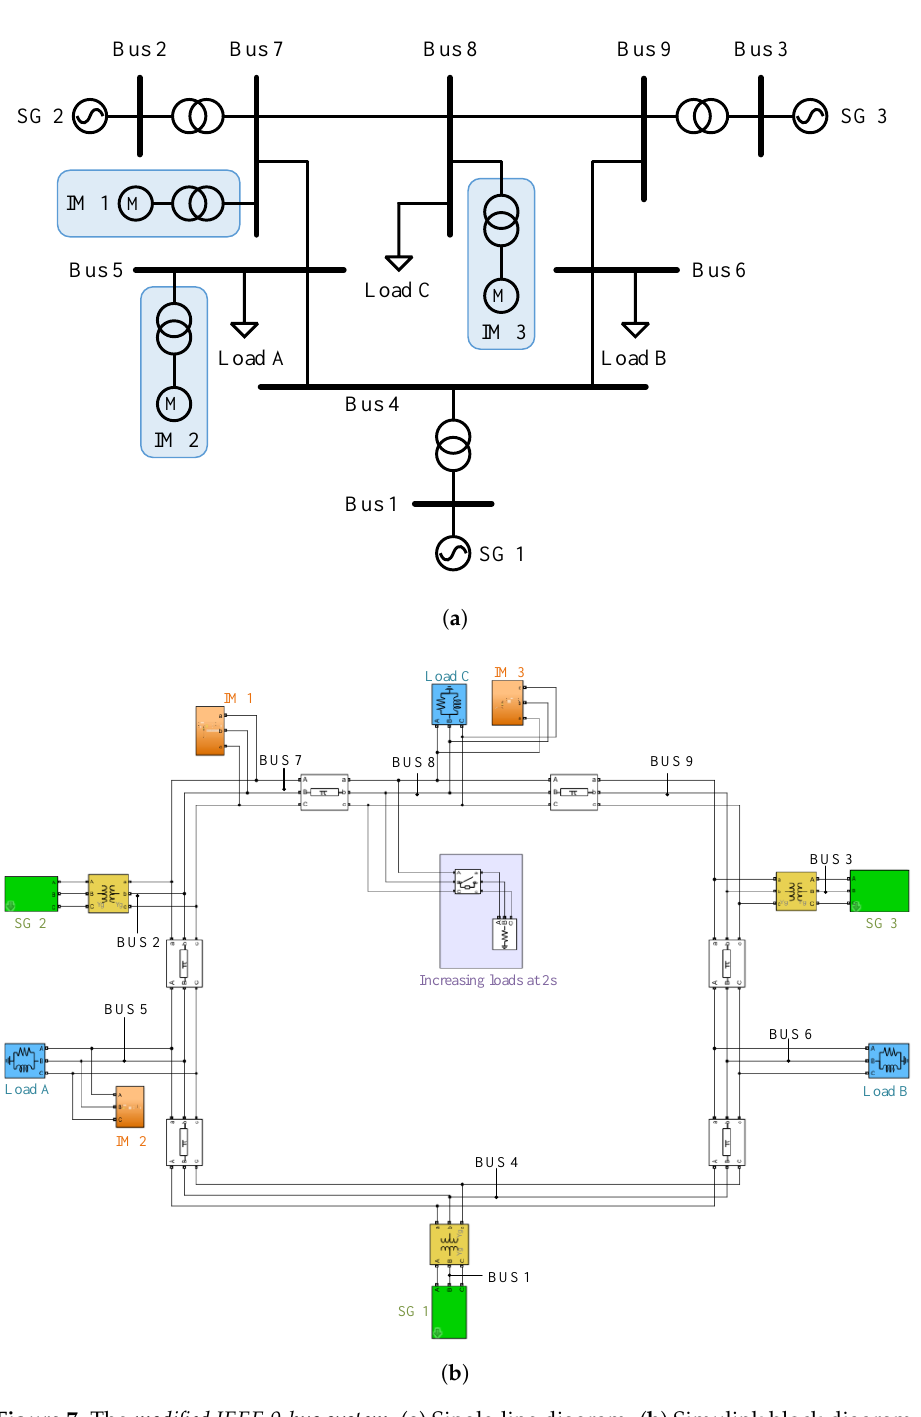
Figure 7. The modified IEEE 9-bus system . ( a ) Single-line diagram. ( b ) Simulink block